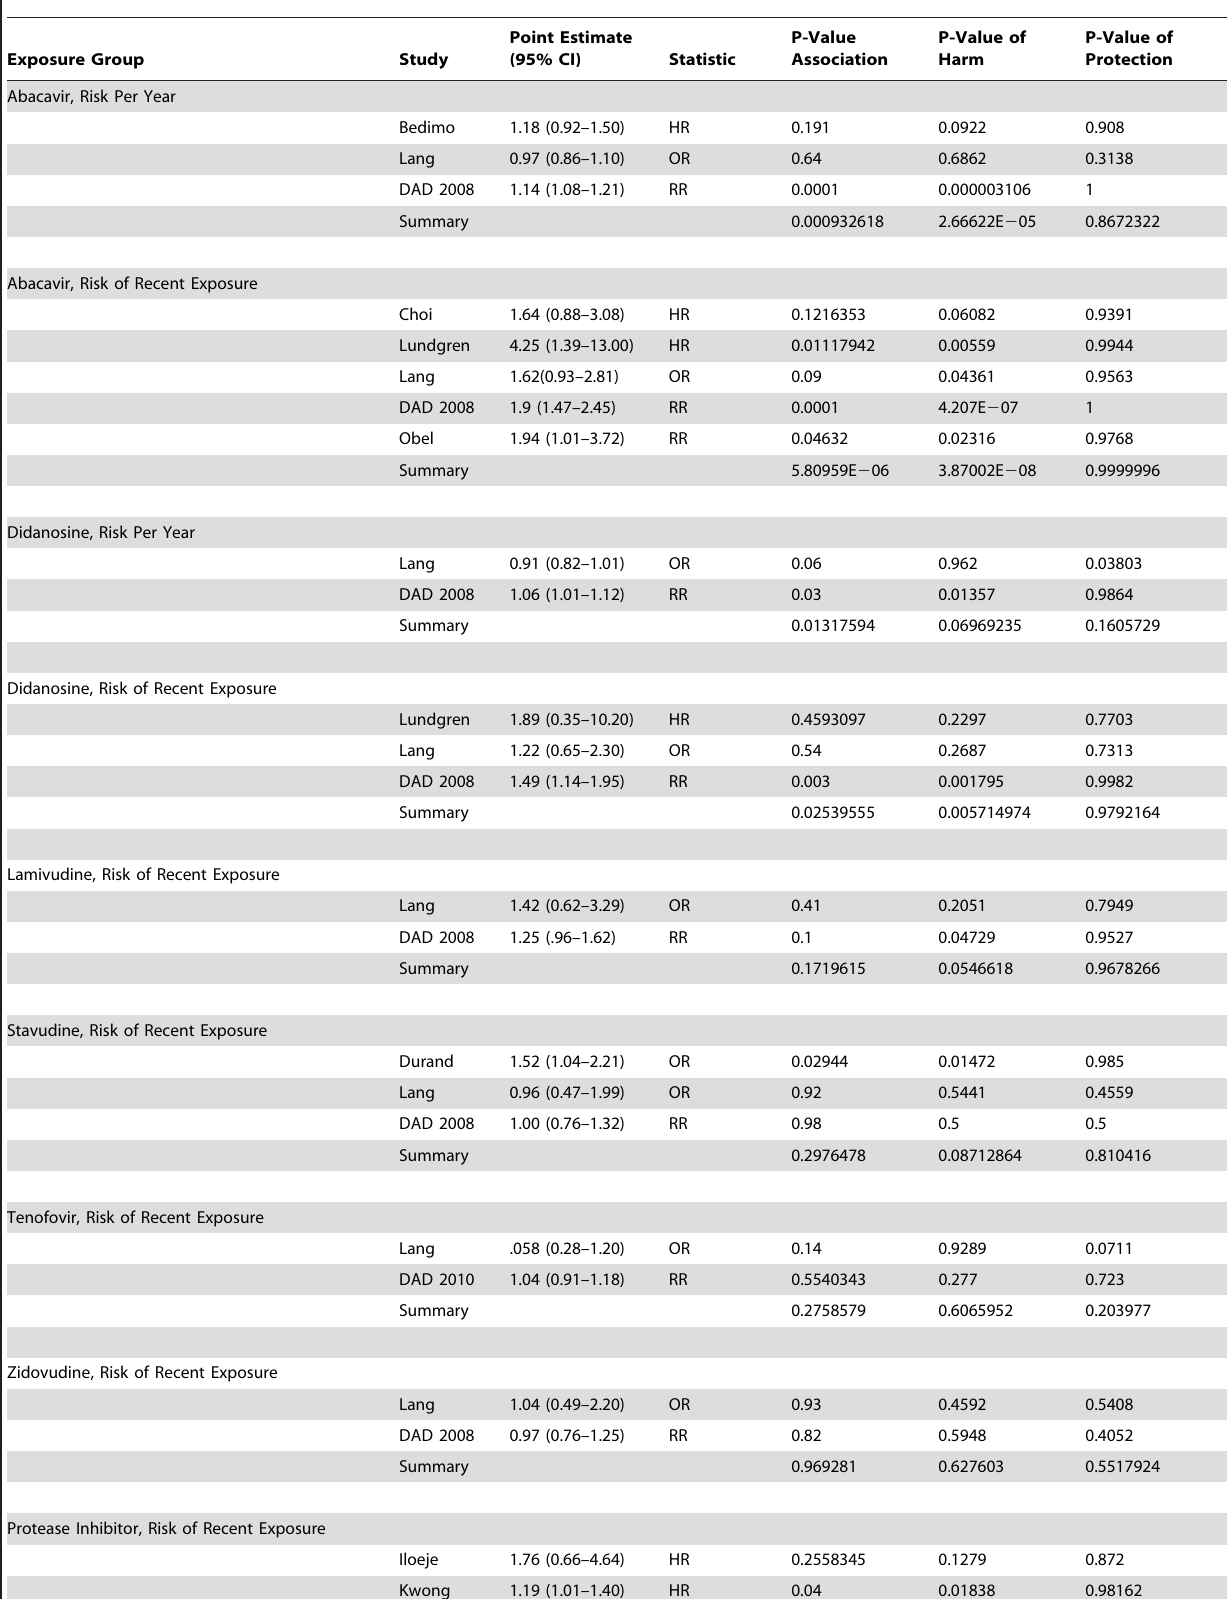
Table 4. Results of Fisher’s P-Value